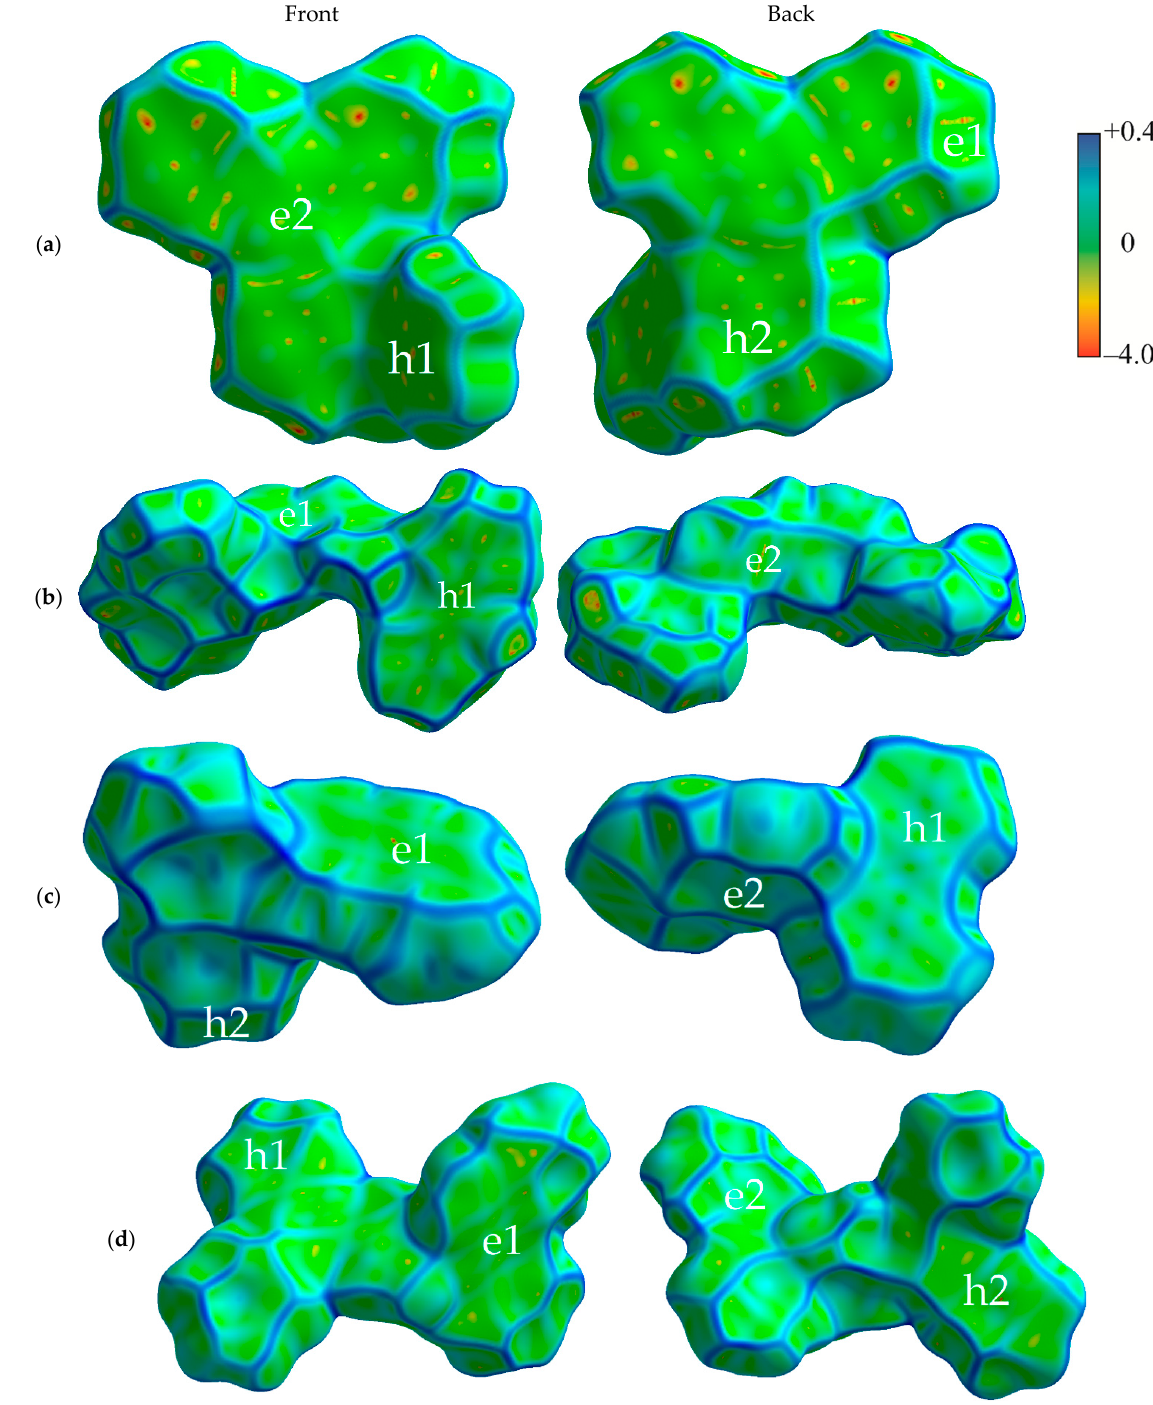
Figure 2. Hirshfeld surfaces (front and back of the molecules) mapped with curvedness [28] for crystalline oTE-DRZ ( a ), CPPD ( b ), PXZ-XO ( c ), and TRZ-c-BPXZ ( d ). The blue color depicts edges (large curvature), the green color depicts relatively flat areas (curvature near unity), and the yellow and red colors depict super flat areas (curvature tended to zero). The labels depict the areas at the surface associated with important contacts for hole (“h”) and electron (“e”) transport.